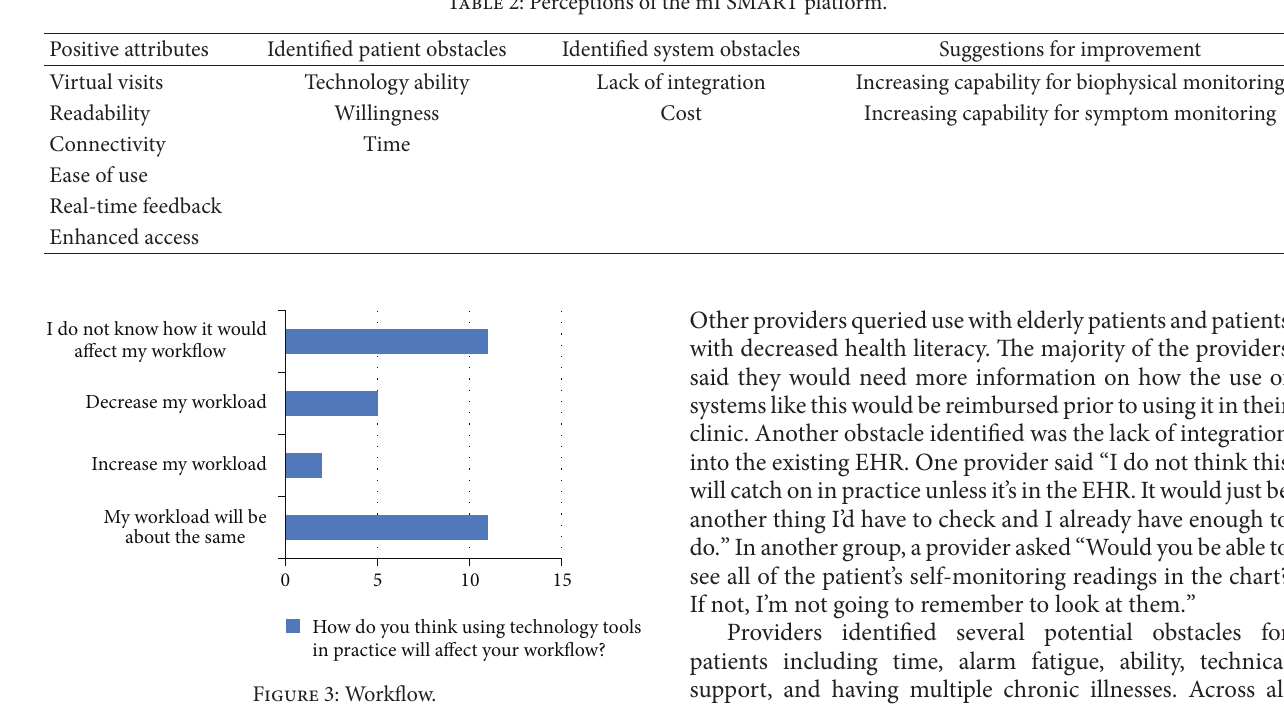
Table 2: Perceptions of the mI SMART platform.